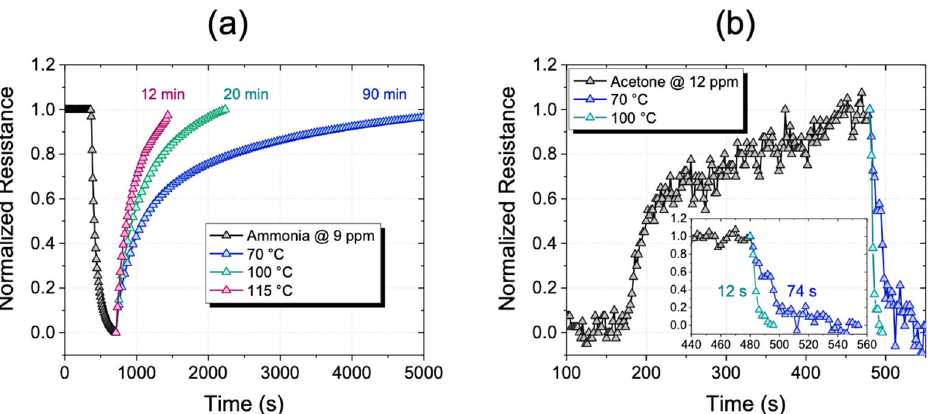
Figure 6. ( a ) Sensor electrical profile with 9 ppm of NH 3 for 5 min. Recovery times at 70 °C, 100 °C, and 115 °C are shown with blue, green and red lines respectively. ( b ) Sensor electrical profile with 12 ppm of acetone for 5 min in the inset, an enlargement of the time scale on the sensor recovery time at temperatures of 70 °C (blue line) and 100 °C (green line).